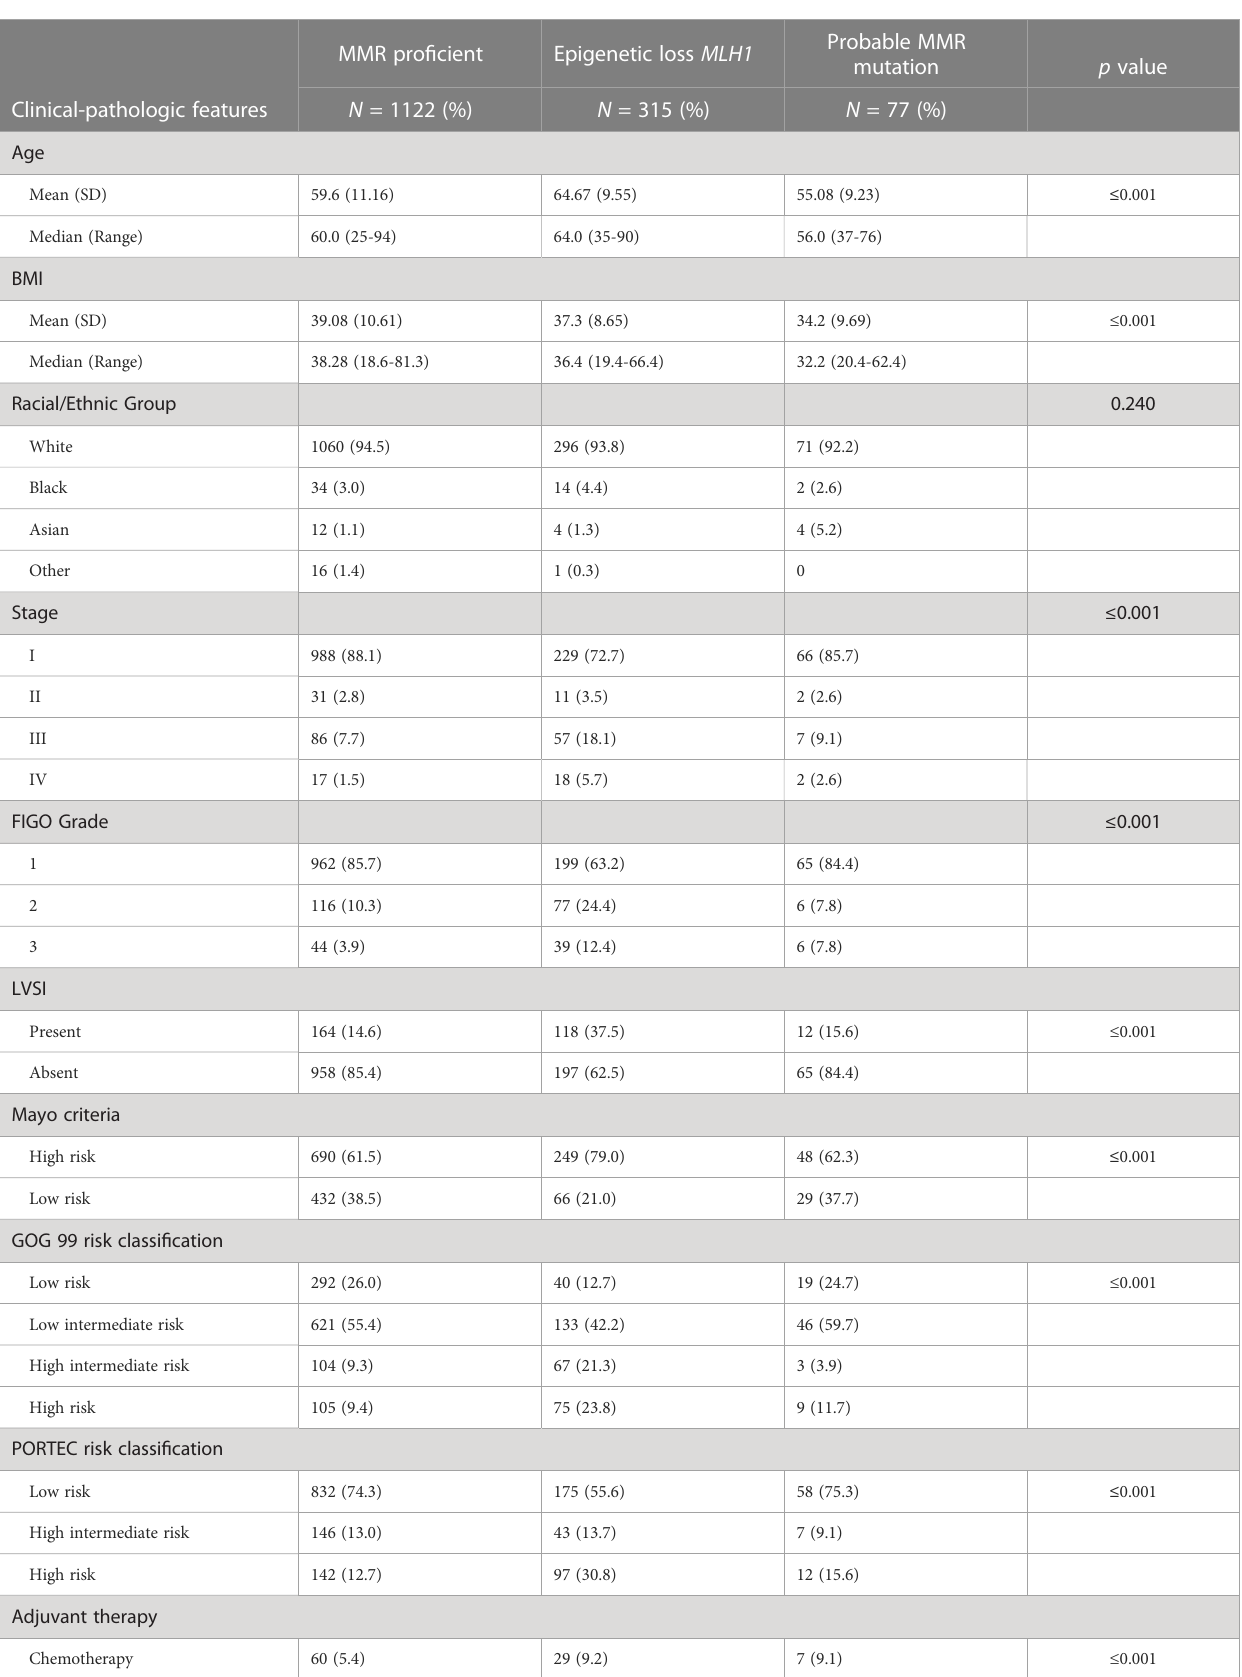
TABLE 1 Clinical-pathologic features of Endometrioid EC by MMR